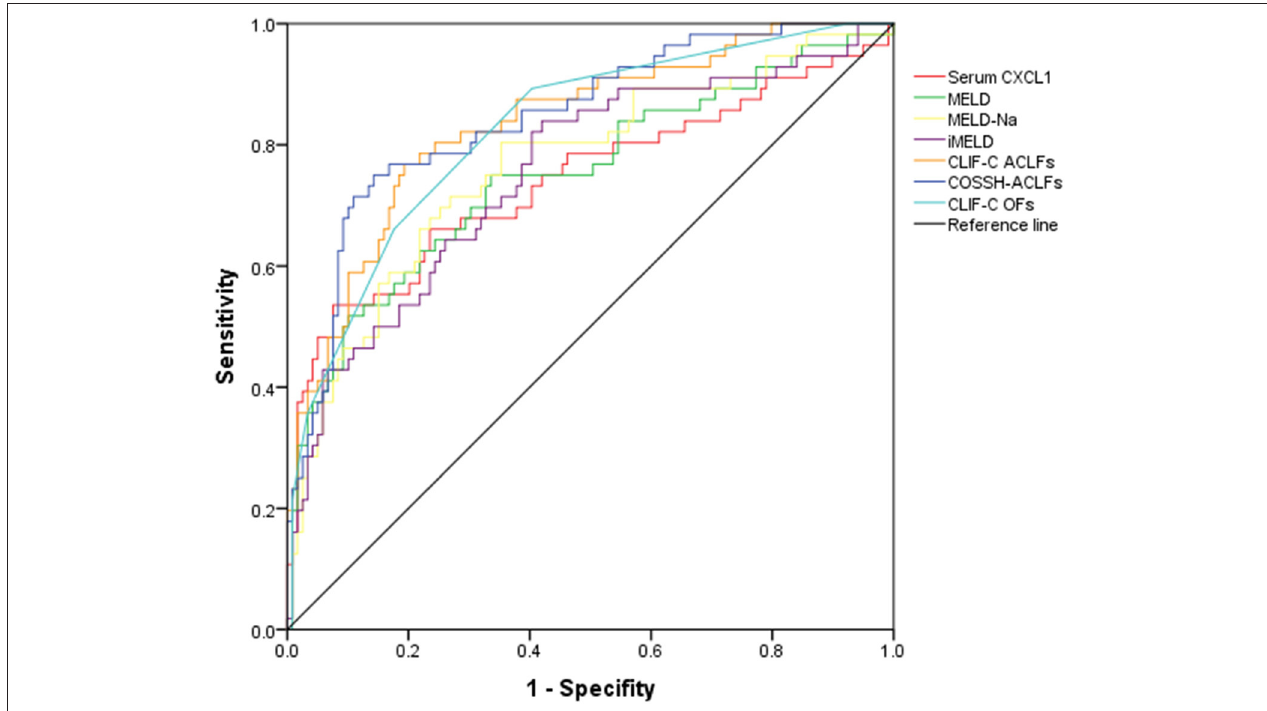
FIGURE 4 | AUROC curves of prognostic models in predicting 28-day mortality in HBV-ACLF groups. AUROC, area under the receiver operating characteristic; HBV-ACLF, hepatitis B virus-related acute-on-chronic liver failure; CXCL1, C-X-C motif chemokine ligand 1; MELD, Model for End-Stage Liver Disease; MELD-Na, MELD-sodium; iMELD, integrated MELD; CLIF-C ACLFs, CLIF-Consortium-ACLF score; COSSH-ACLF score, Chinese Group on the Study of Severe Hepatitis B-ACLF; CLIF-C OFs, CLIF-Consortium Organ Failure Score.